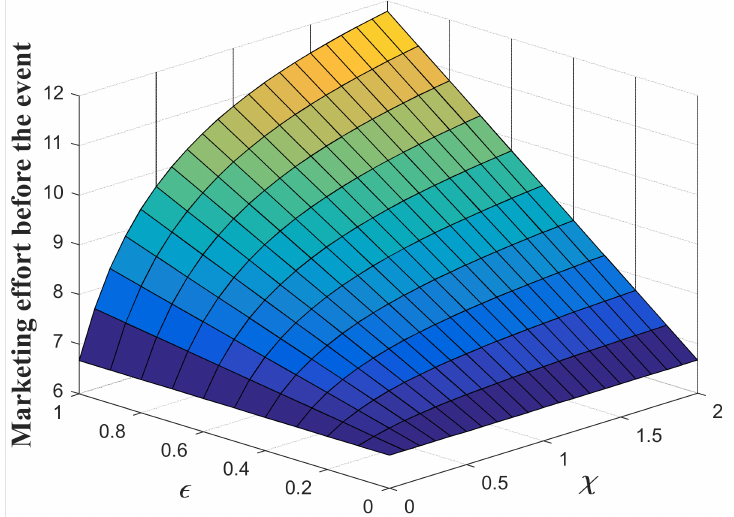
Figure 1. Marketing effort before the favorable